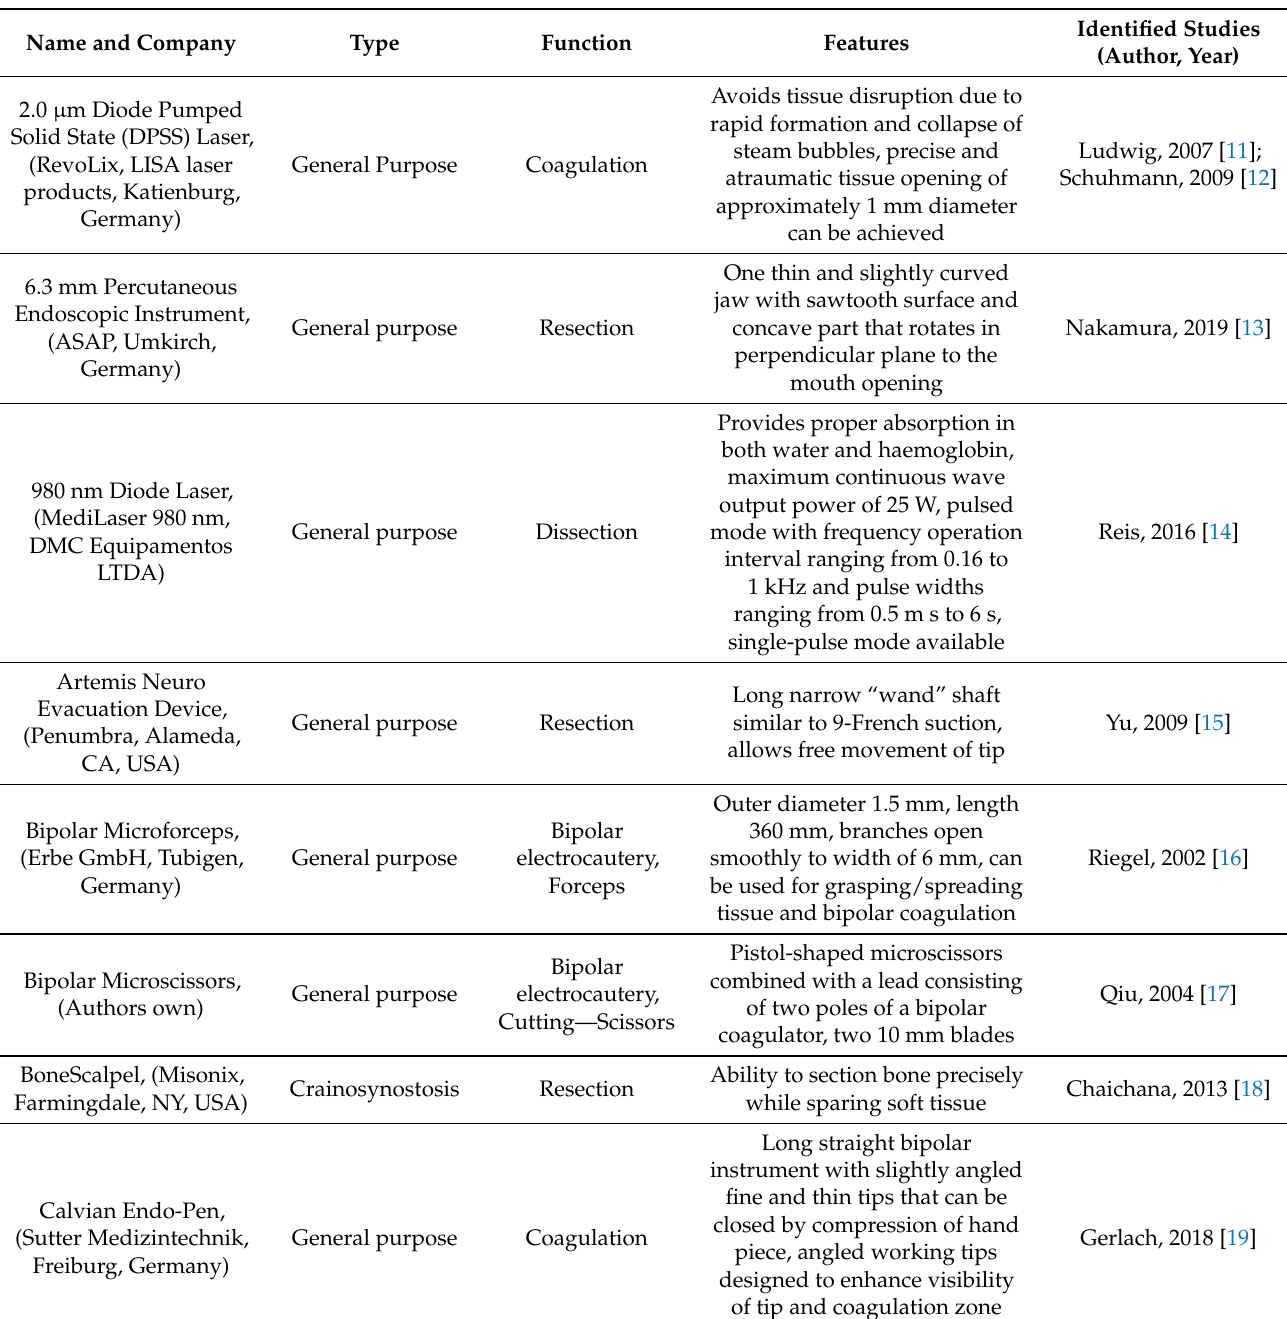
Table 1. Summary of available instruments for endoscopic or endoscope-assisted